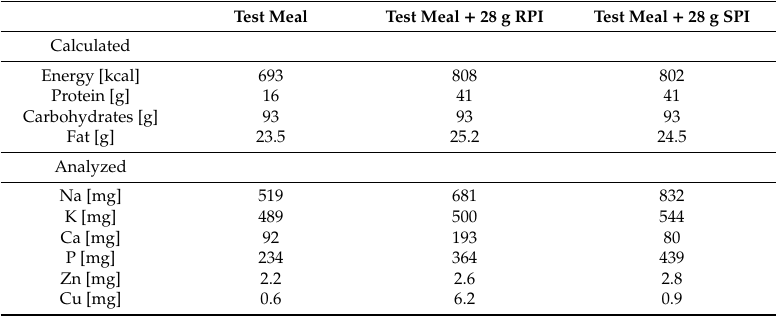
Table 1. Energy and quantities of macronutrients and minerals in the three test meals. Test